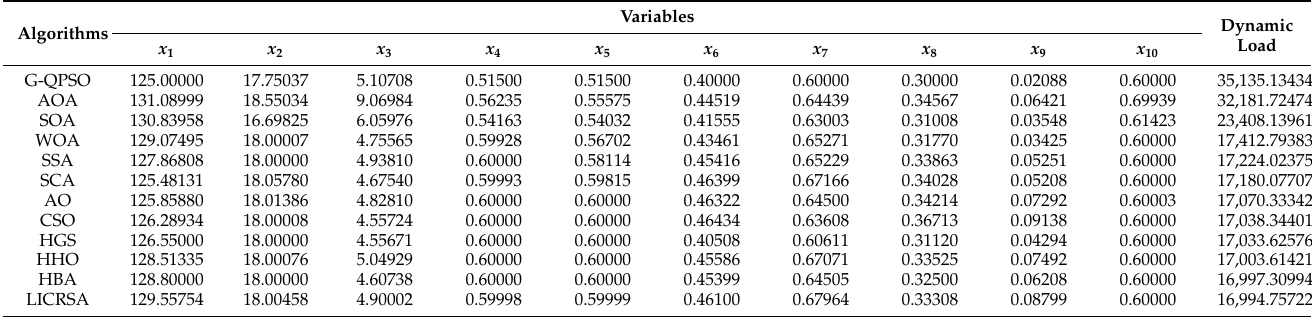
Table 16. Numerical results for the rolling element bearing problem.